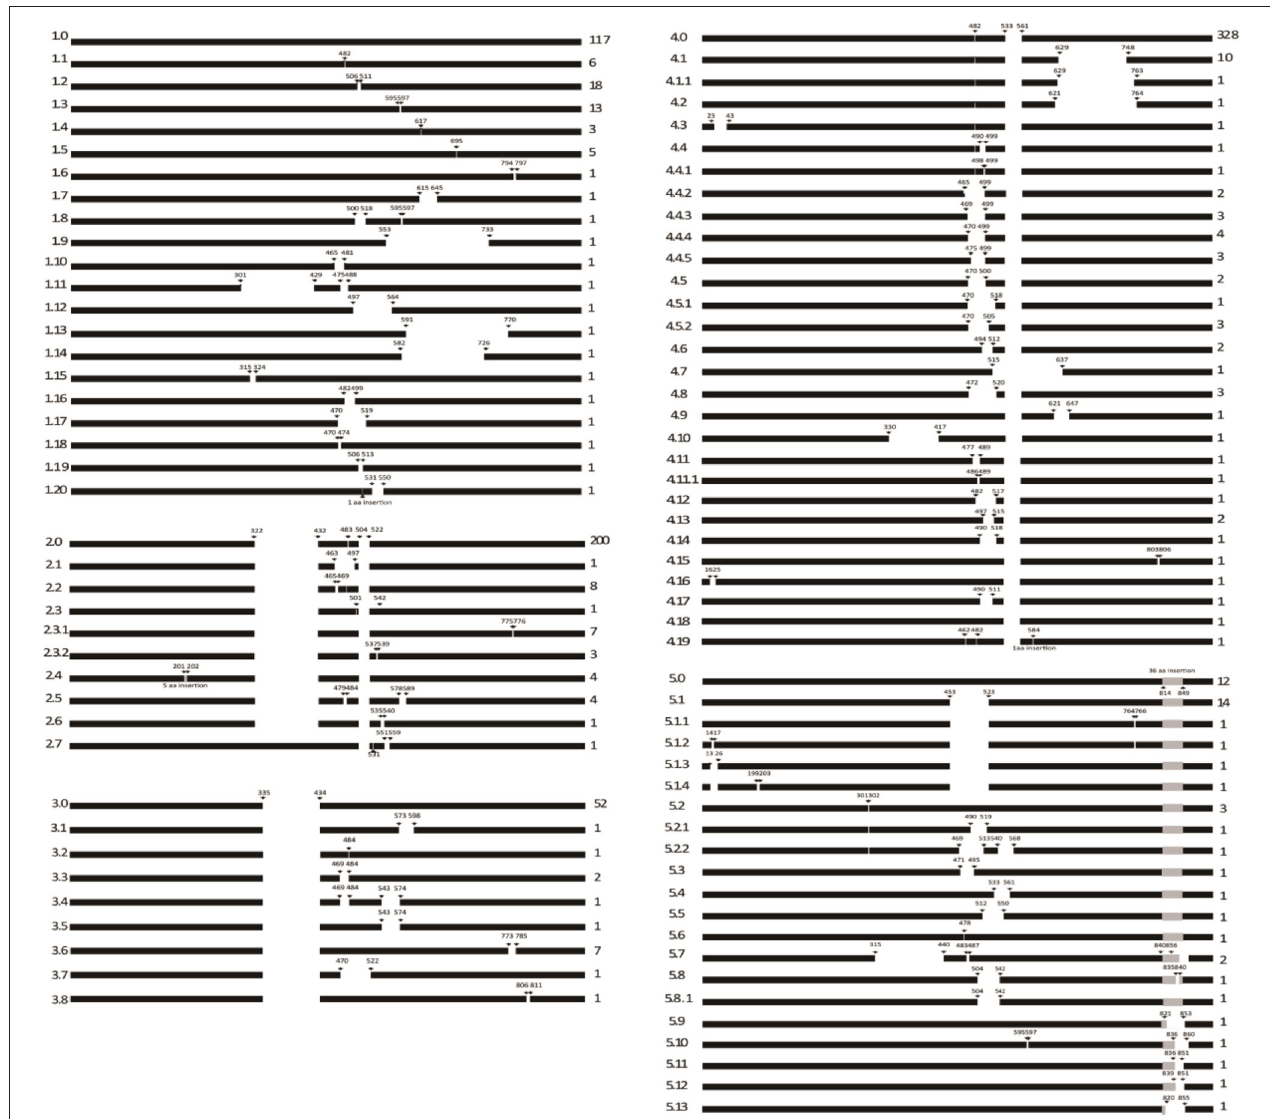
FIGURE 1 | Systematic indel patterns of NSP2 based on 907 PRRSV-2 sequences. The indel patterns of NSP2 are divided into five main categories. The arrows and numbers indicate the indel locations in NSP2 using the position in the VR-2332 strain as a reference. Values on the right represent the numbers of